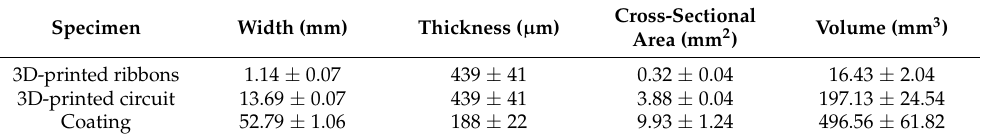
Figure 2. Electrical and electrothermal characterization as a function of nanoparticle content and specimen morphology. ( a ) Electrical conductivity, ( b ) average temperature increment with respect to room temperature, ( c ) examples of Joule’s heating test for the 3D-printed circuit and coating with 1.0% CNT and 0.5% GNP, and ( d ) IR images taken during Joule’s heating tests. Table 1. Morphological